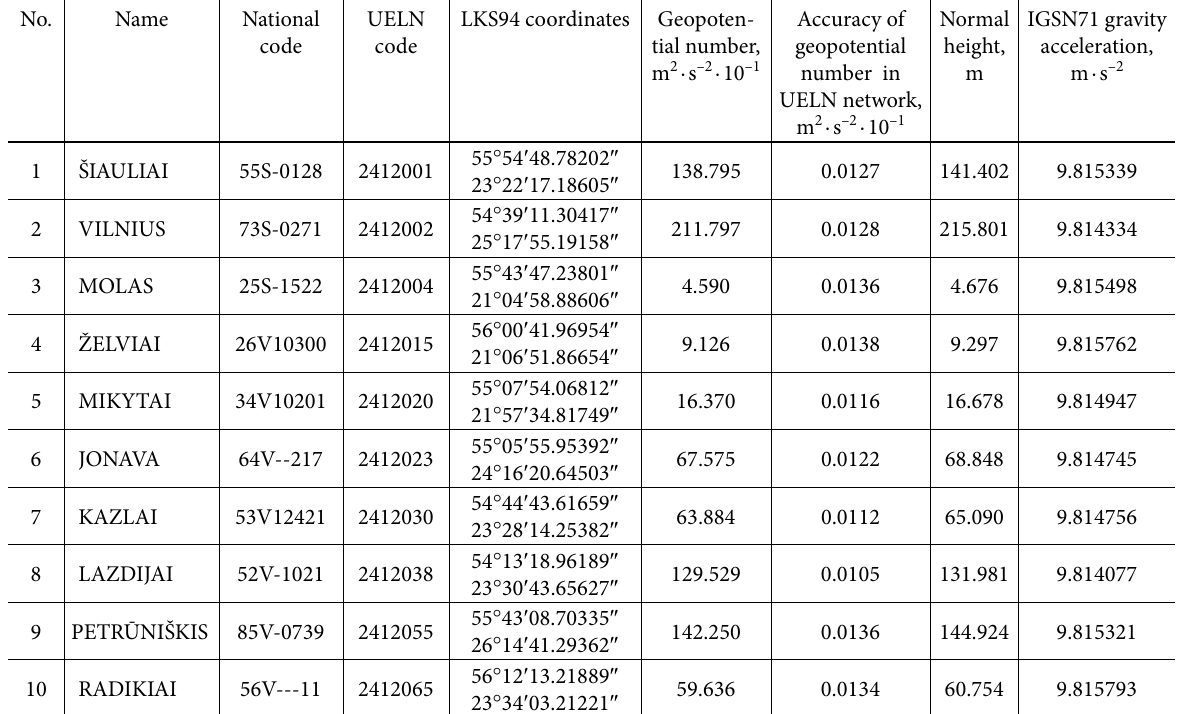
Table 4. Datum points of the Lithuanian NGVN